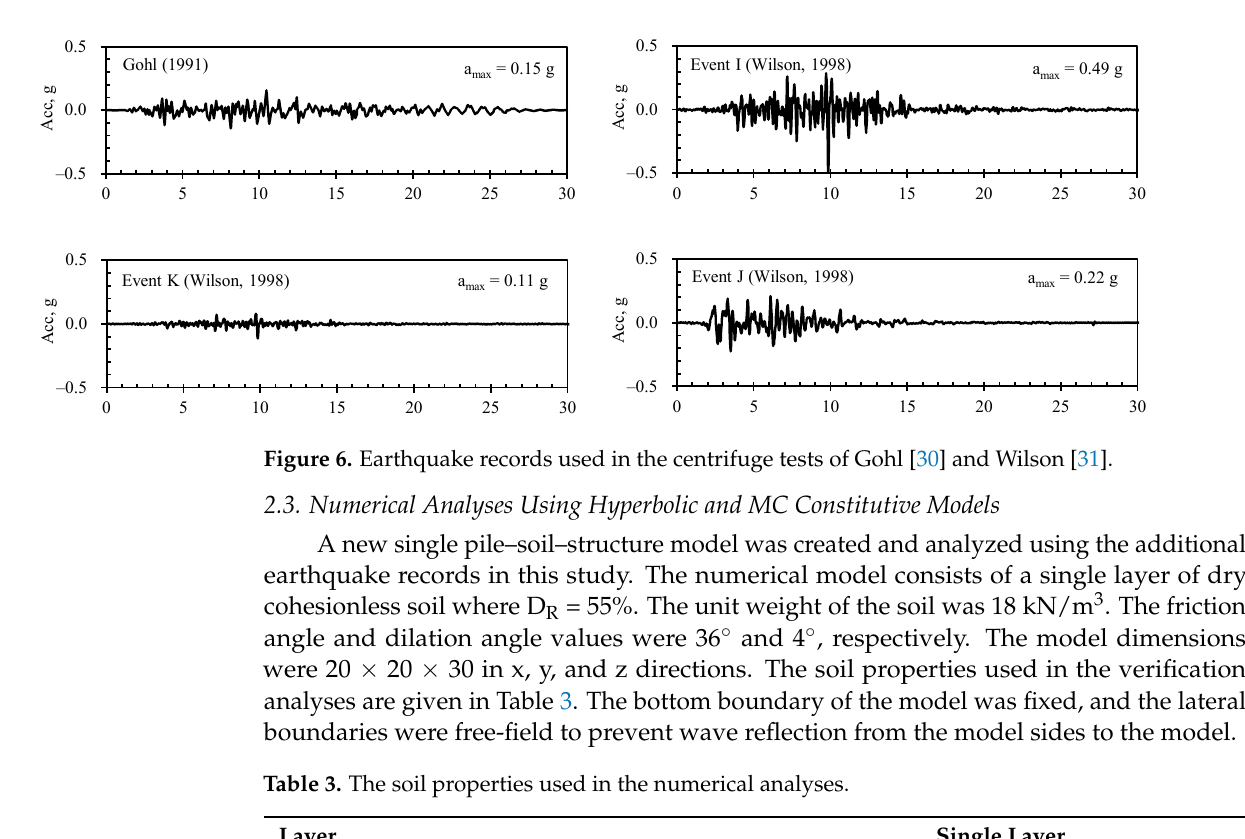
Table 3. The soil properties used in the numerical analyses.